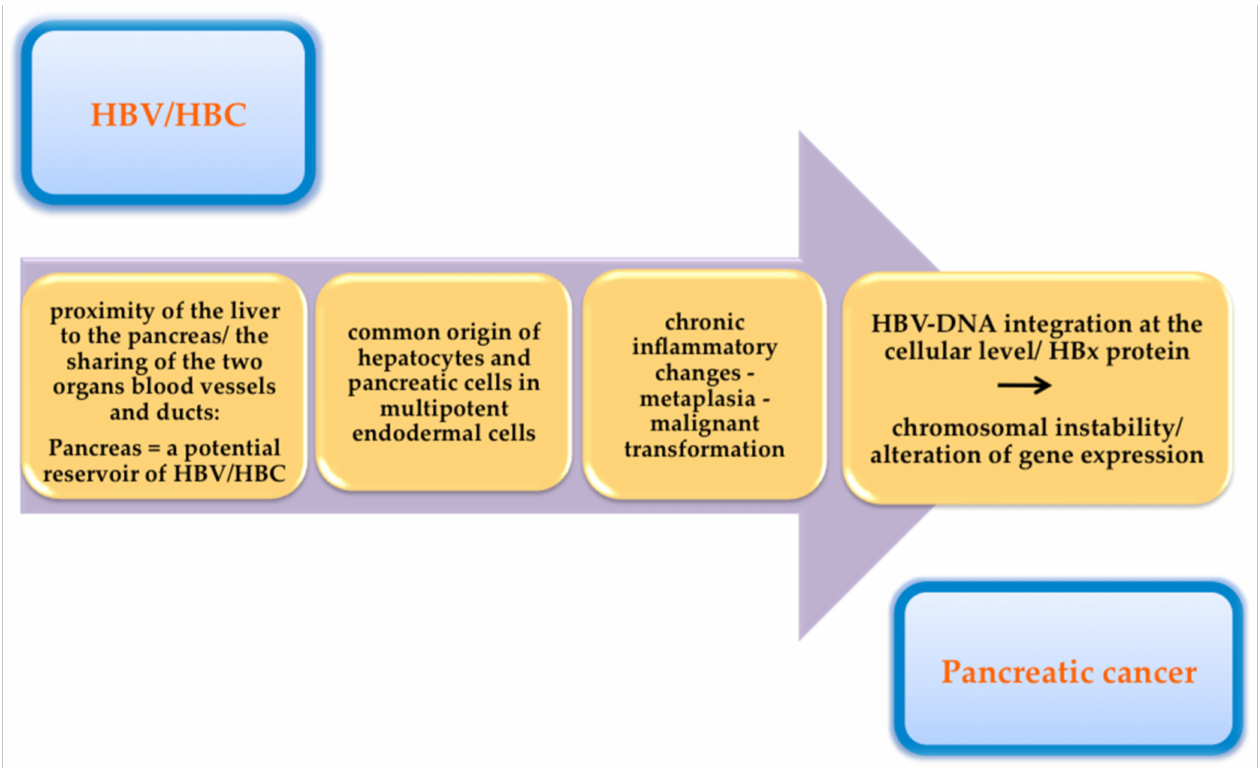
Figure 2. The pathophysiological mechanisms by which hepatotropic viruses may contribute to the development of pancreatic